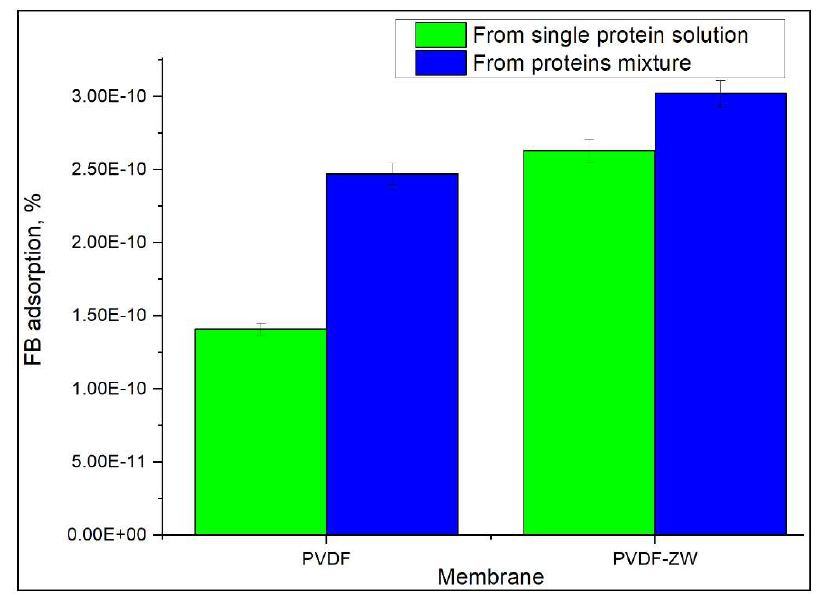
Figure 8. Comparison of FB adsorption from its single solution and protein mixture.